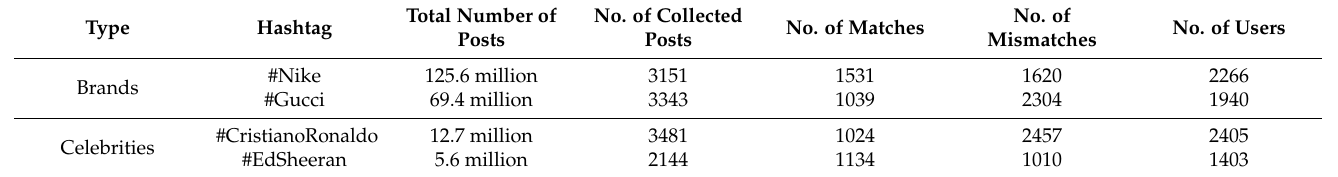
Table 2. The distribution of the collected data with additional statistical information for each